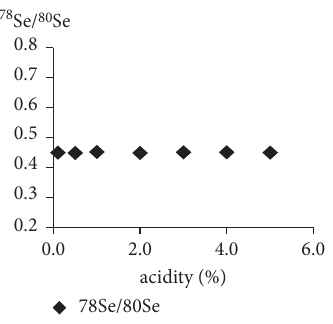
Figure 2: The value of 78 Se and 80 Se with acidity. Table 2: Precision for potassium and selenium in human serum by two-step ID-ICPMS.